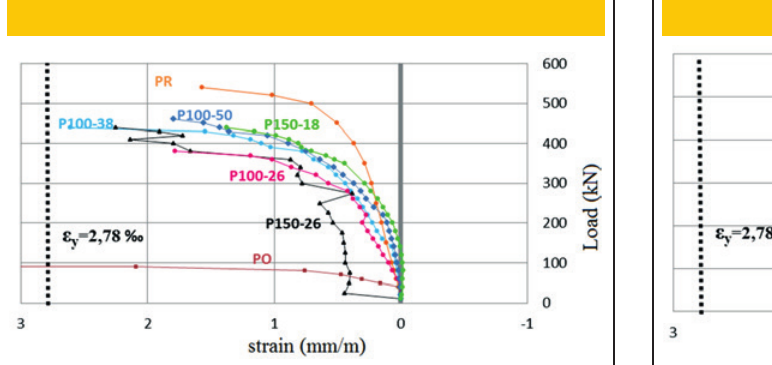
Figure 11 – Load vs compressed steel strain